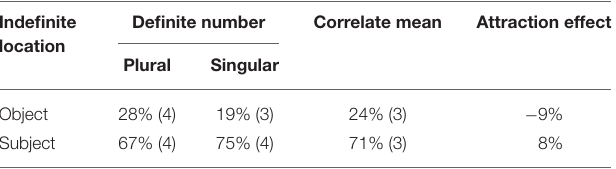
TABLE 1 | Experiment 1: percent subject response selected.